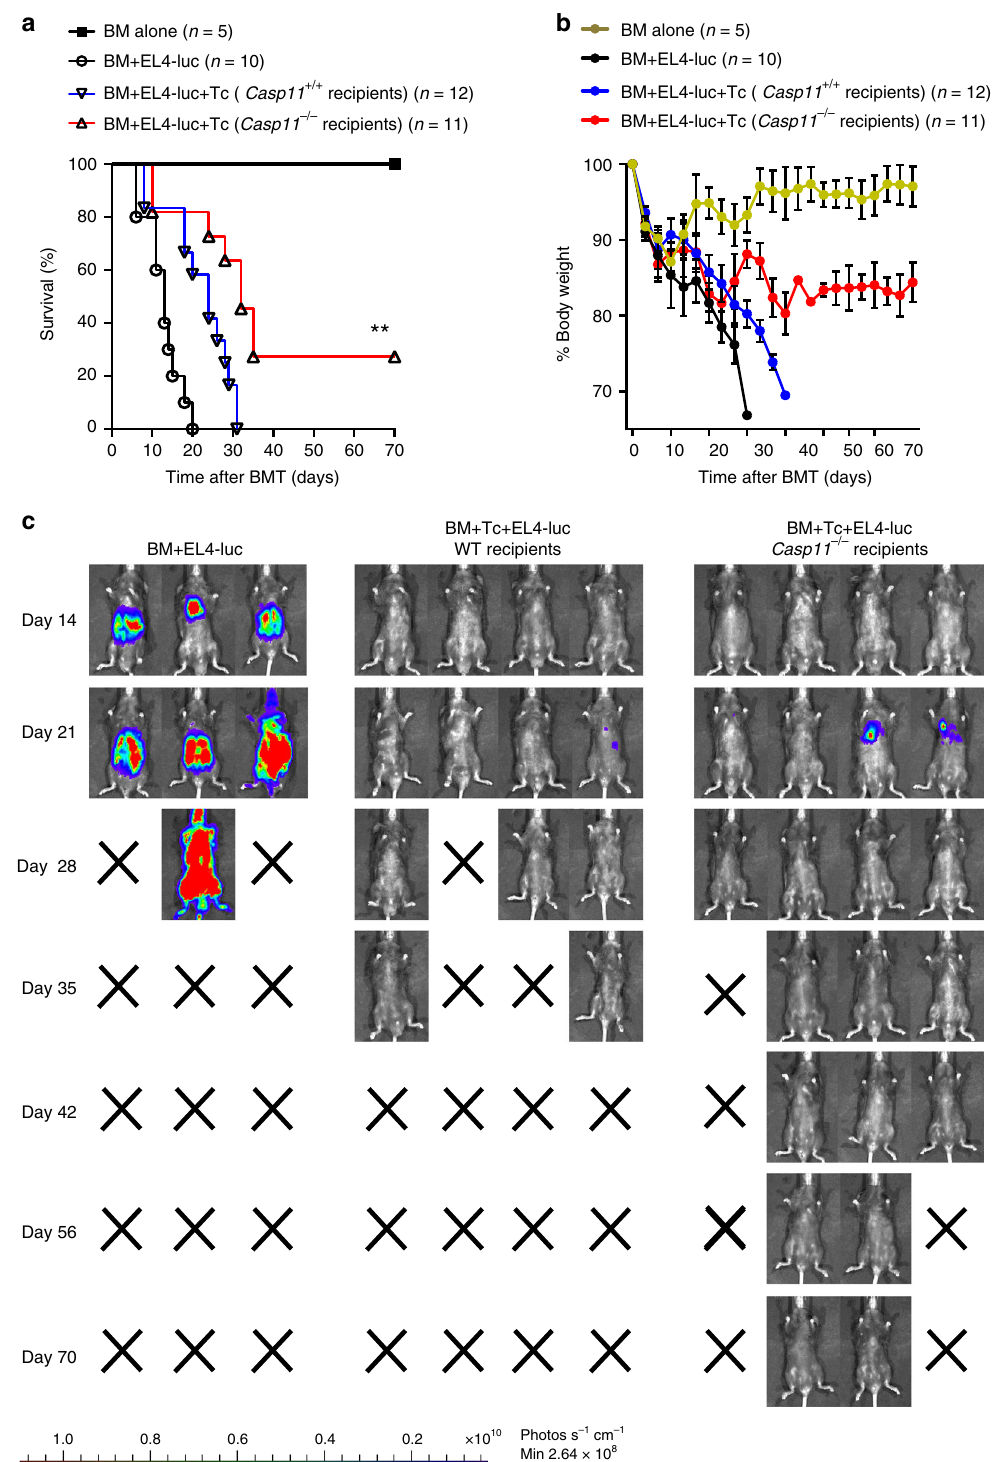
Fig. 7 Caspase-11 de fi ciency preserves graft-versus-leukemia (GVL) activity. a Survival of Casp11 + / + ( n = 12) and Casp11 − / − ( n = 11) recipients had received lethally irradiation (1100cGy) and transplanted with 5 × 10 6 BALB/c T cell-depleted bone marrow (TCD-BM) cells alone or in addition to 3 × 10 6 total T cells from BALB/c mice with 3 × 10 5 EL4 luciferase-transduced lymphoma cells at the time BM transplant (BMT) was shown. Differences in animal survival were analyzed by log-rank test. ** P = 0.0039 ( Casp11 − / − compared with vehicle-treated controls). b Casp11 + / + ( n = 12) and Casp11 − / − ( n = 11) recipients were monitored throughout the experimental period for weight change by every 3 to 5 days. c Tumor expansion in Casp11 + / + and Casp11 − / − recipients was shown by luciferin intraperitoneal injection and whole-body bioluminescent imaging (BLI) was taken every 14